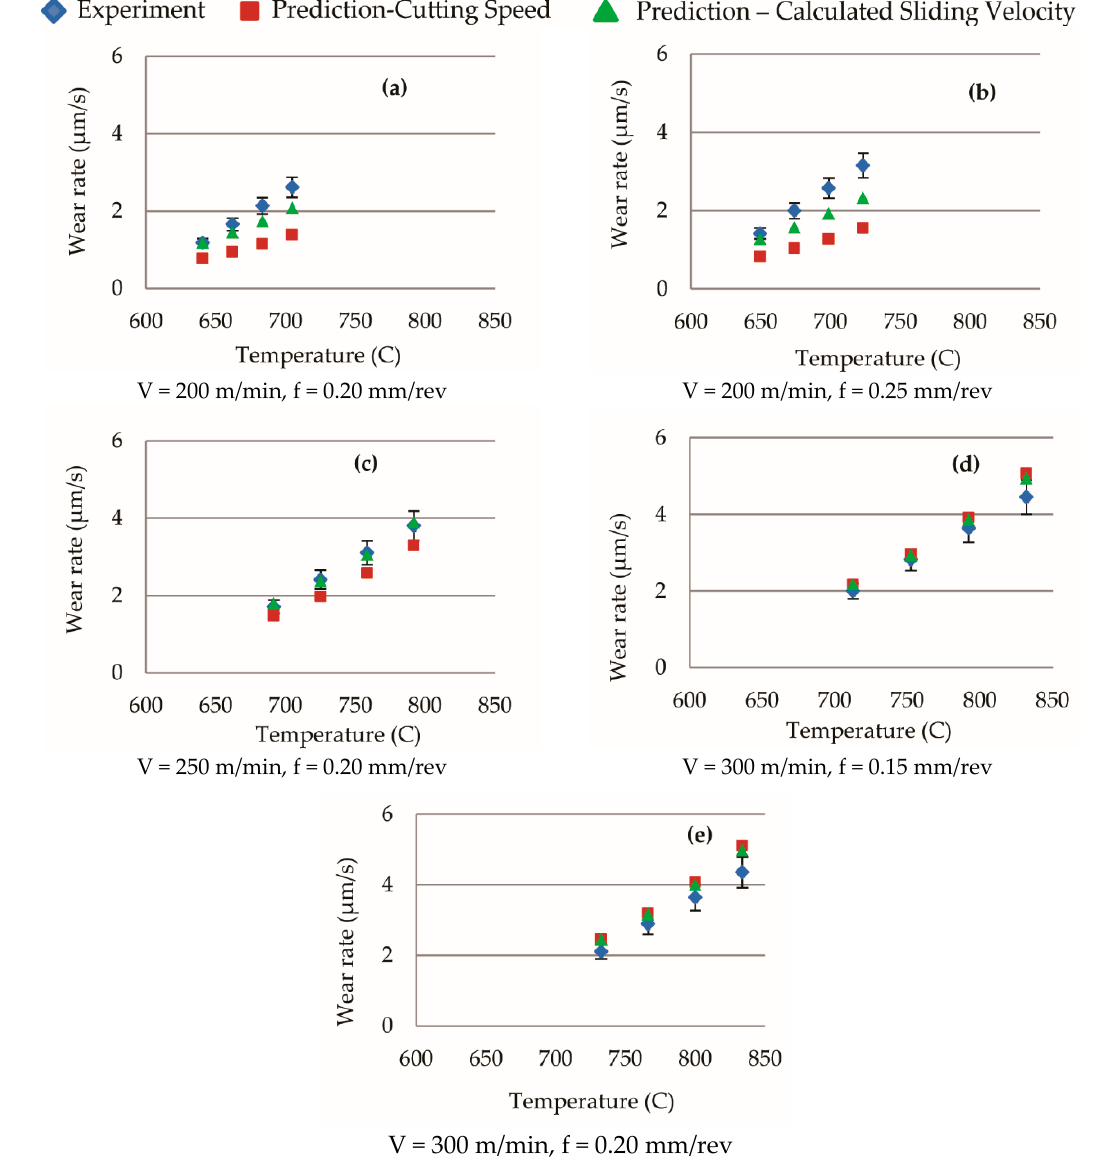
Table 4. Model constants for the calibrated equation based on two boundary conditions.